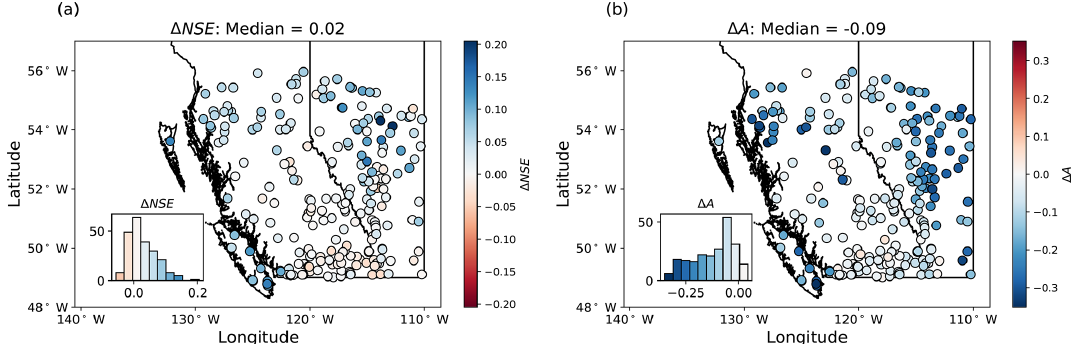
Figure A5. The difference in model performance between the bulk model and fine-tuned model for both (a) NSE and (b) sensitive area A . The insets show histograms of (cid:49) NSE and (cid:49)A across all stations. Negative values indicate that fine-tuning reduced NSE or A , while positive values indicate that fine-tuning increased NSE or A . (cid:49) NSE is most positive (indicating the greatest improvement through fine-tuning) along the west coast and northern regions of both British Columbia and Alberta. (cid:49)A is most negative (indicating that fine-tuning reduces the size of the sensitive areas) along the west coast, in northern British Columbia, and throughout Alberta. One stream gauge station experienced a substantial increase in NSE from fine-tuning ( (cid:49) NSE > 1 . 0), but the histogram and colour bar are clipped for